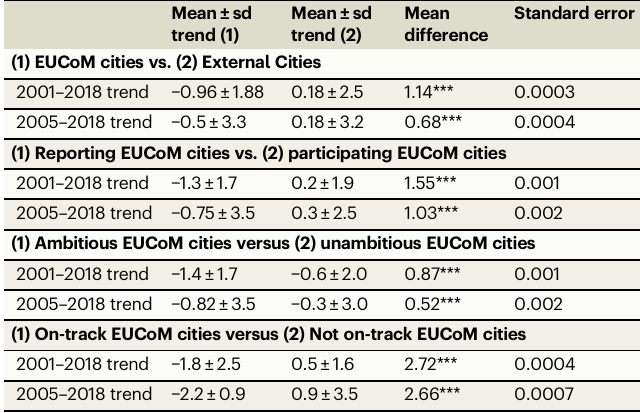
Table 1 | Difference in annual per capita emissions reduction trend between different comparison